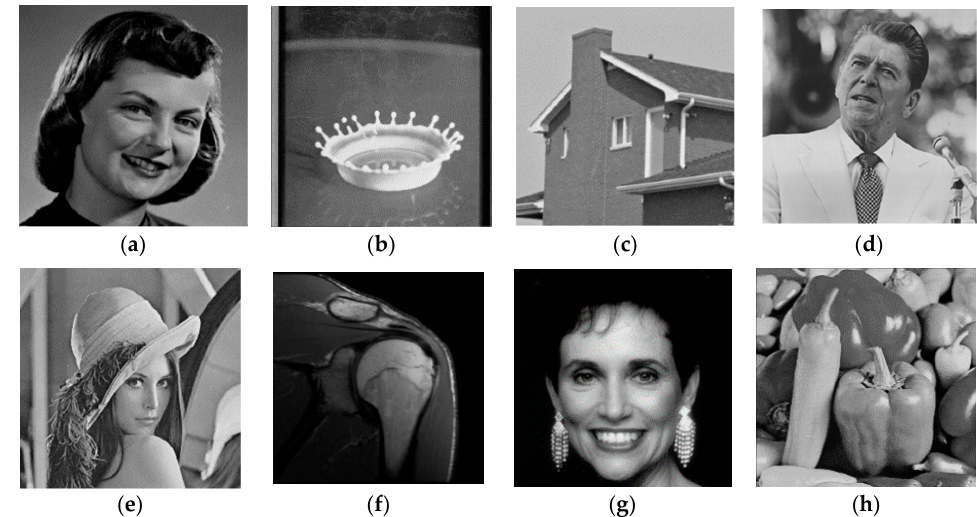
Figure 3. Original images. Top row: from left to right, ( a ) Girl.bmp, ( b ) Milk drop.tiff, ( c ) House.png,